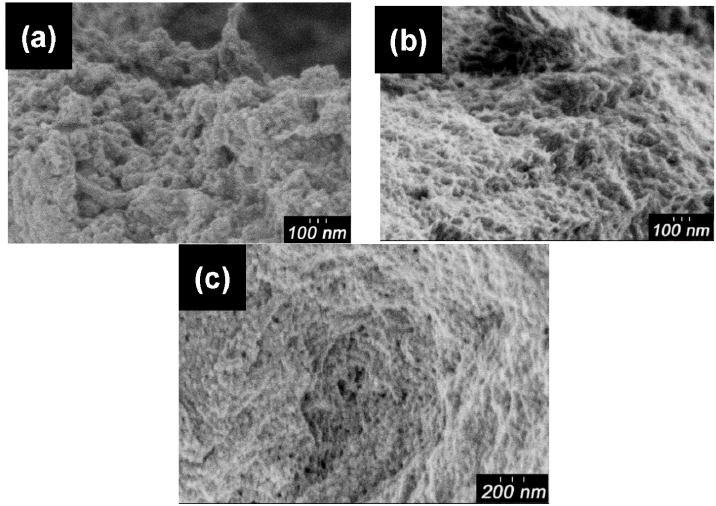
Figure 11. SEM images of carbonized PA-NF7 ( a ); PA-NF8 ( b ); and PA-NF9 ( c ). PA-NF7, and PA-NF8 using 1% CNF (EGUS) suspension (CNF/aniline = 100, feed %).